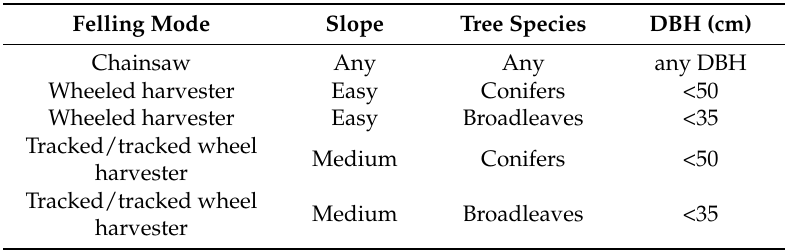
Table 3. Applied harvesting systems with regard to terrain slope and DBH.